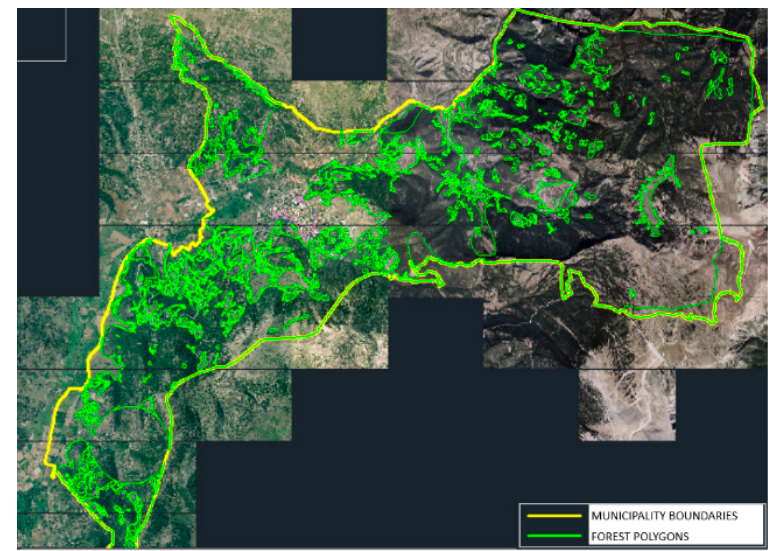
Figure 11. Overlay of the forest maps on the orthophoto. Source: [35].